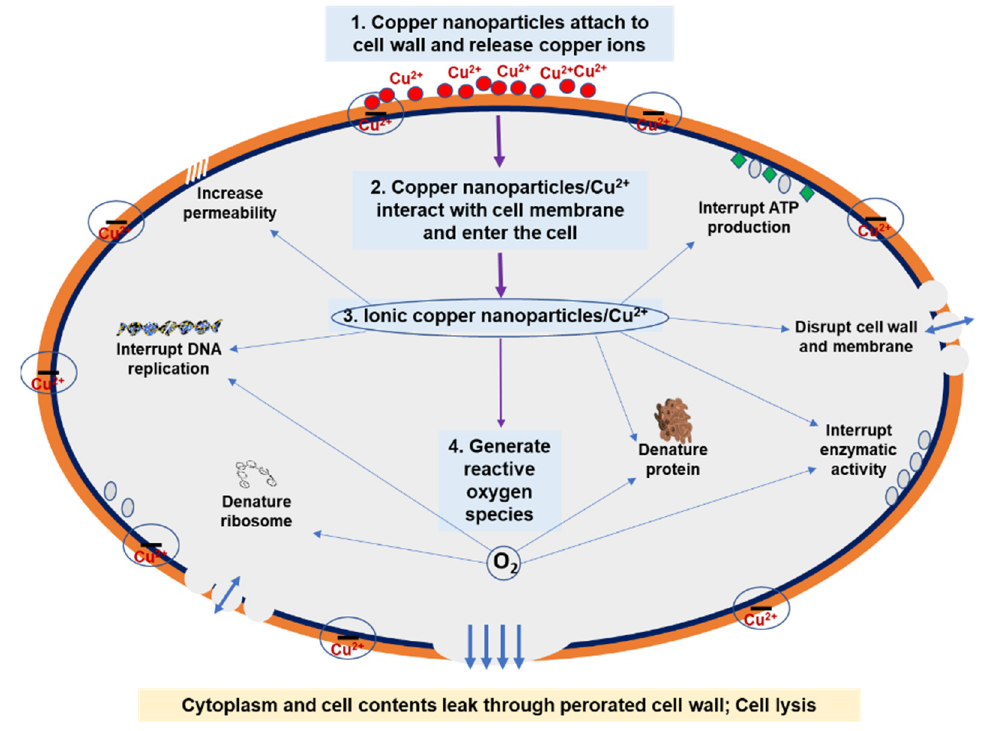
Figure 1. Antibacterial mechanism of copper nanoparticles.